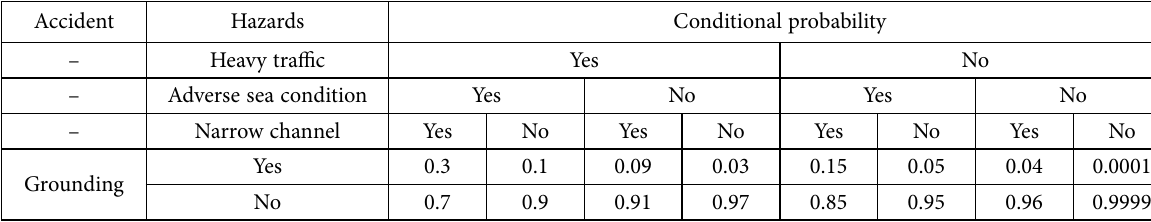
Table 2. Sample of the CPTs in the BN